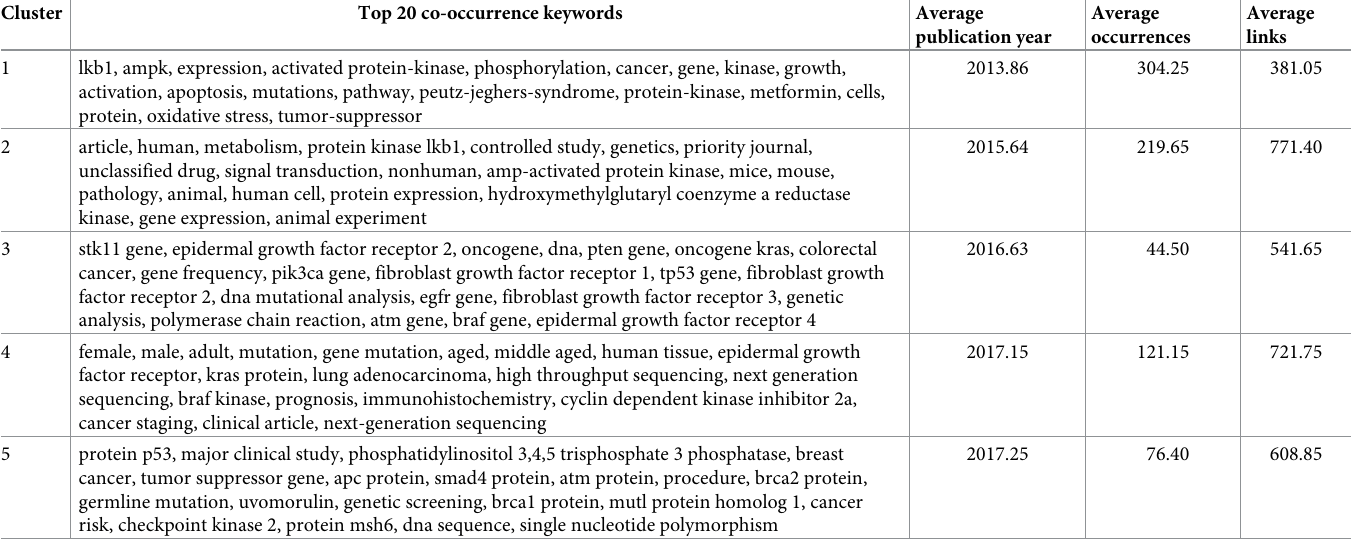
Table 6. Top 20 keywords in the 5 clusters of LKB1 research from 2000 to 2021. Cluster Top 20 co-occurrence